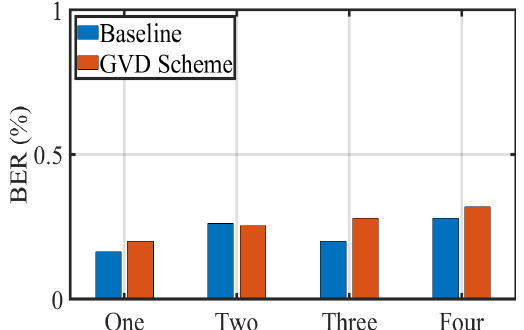
Figure 12. BER with variable LED